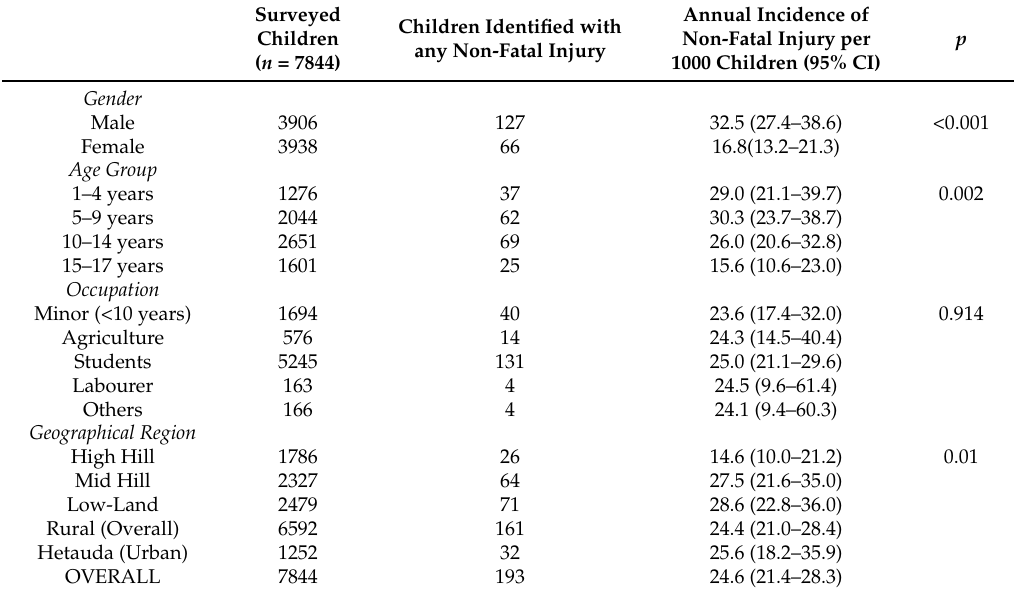
Table 1. Annual incidence of non-fatal injuries in Makwanpur district, Nepal.